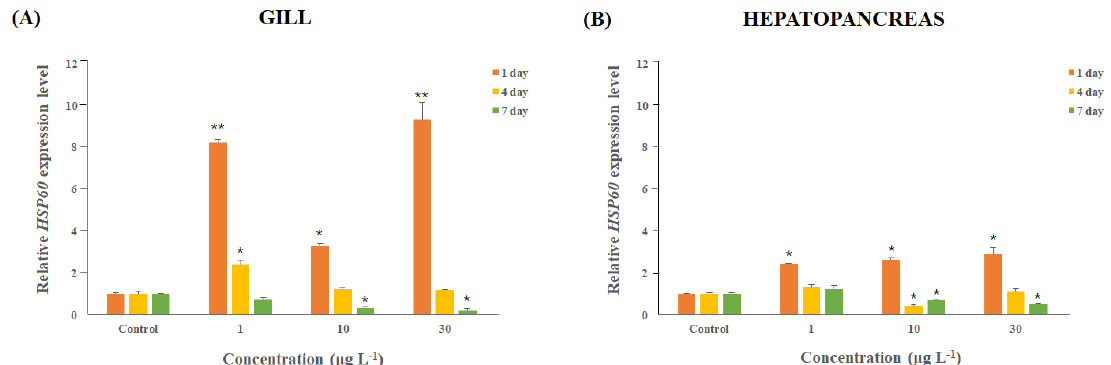
Figure 4. Expression analysis of HSP60 in the ( A ) gill and ( B ) hepatopancreas of Macrophthalmus japonicus exposed to 1, 10, and 30 µ g L − 1 DEHP after 1, 4, and 7 days. Values were normalized against GAPDH . Bars indicate the standard deviation of the mean. Statistically significant differences are represented by asterisks as * P < 0.05 and ** P < 0.01, compared to controls (control ratio value = 1).